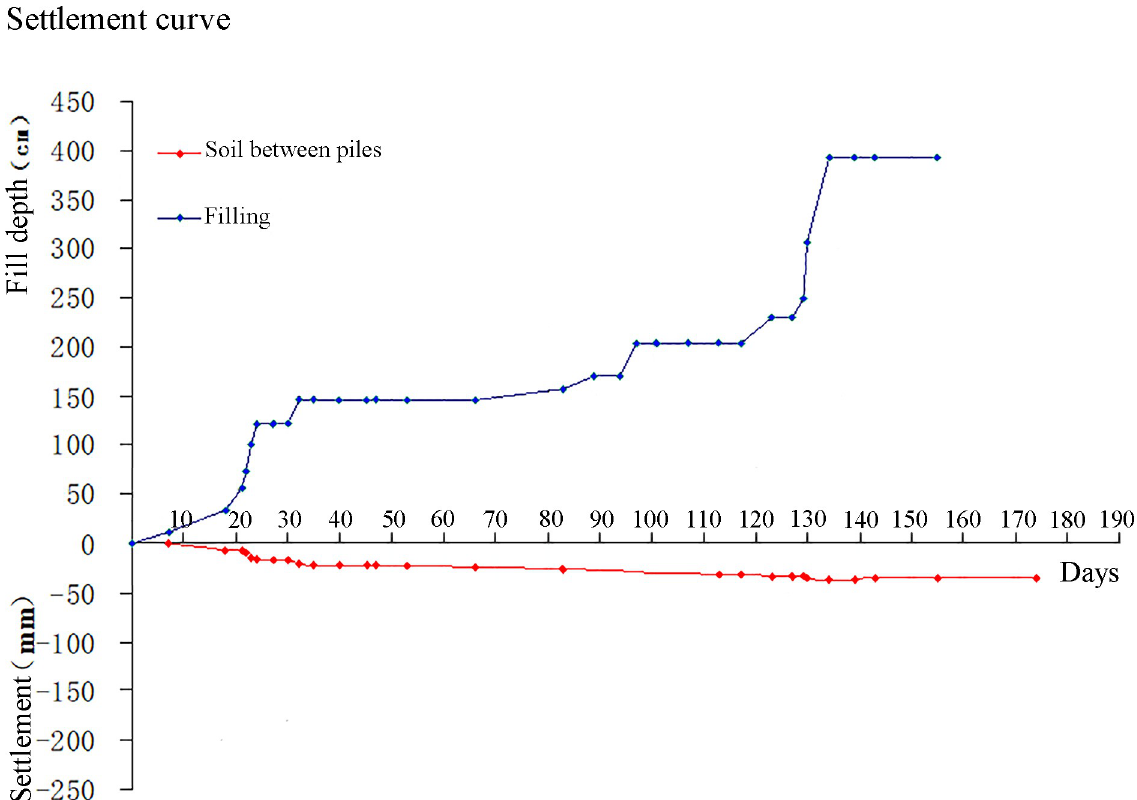
Fig 12. The time-dependent settlement of the soil between piles.